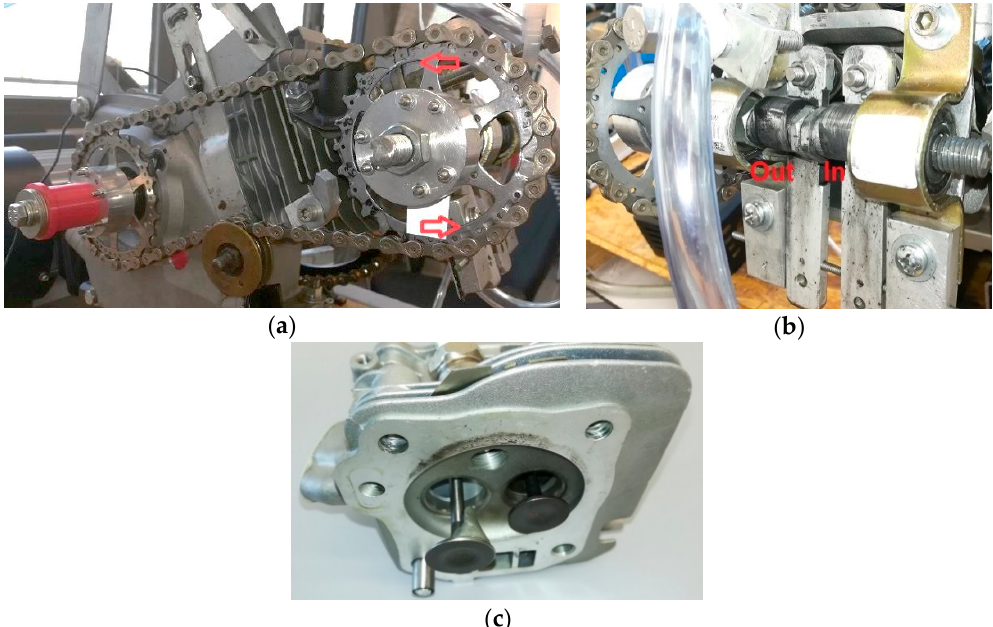
Figure 7. ( a ) 1:1 camshaft drive for the 2-stroke. ( b ) Camshaft with highly overlapping lobes. ( c ) Head with elevated valves and a jockey made from heat resistant epoxy attached to inlet valve.